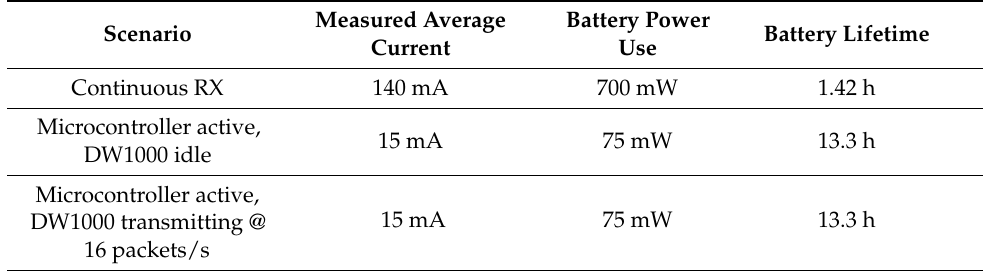
Table 6. System power use in various scenarios and associated lifetime on a 5 V, 200 mAh battery. Measured Average Battery Power Battery Lifetime Scenario Current Use Continuous